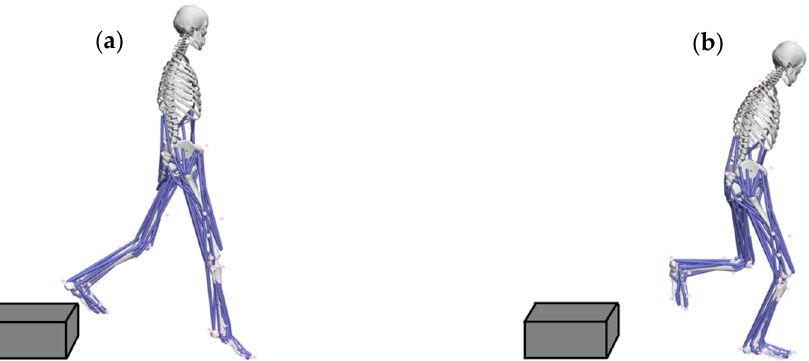
Figure 1. Key events of single-leg landing: ( a ) initial foot contact; ( b ) maximum knee flexion angle.